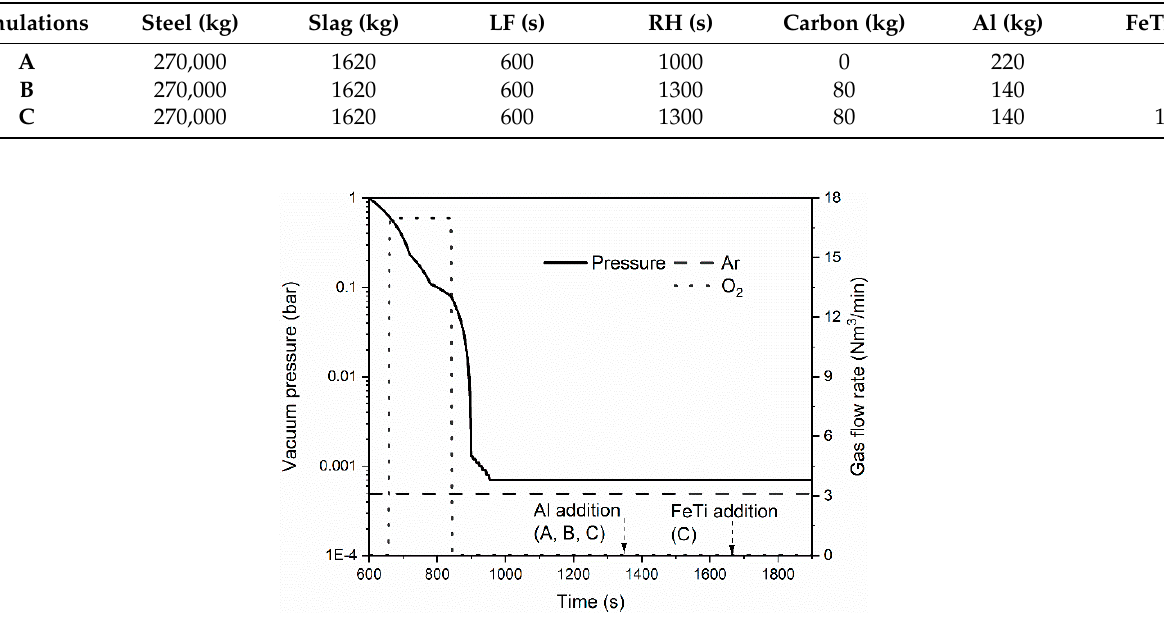
Figure 4. The assumed pressure, oxygen, and Ar flow rates for RH treatment [2].